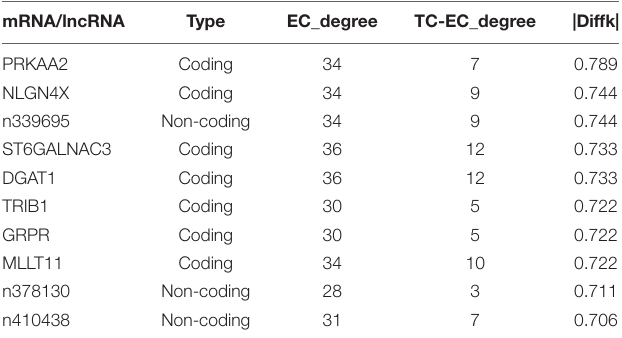
TABLE 4 | Top 10 differential mRNAs or lncRNAs between the TC–EC model and EC.